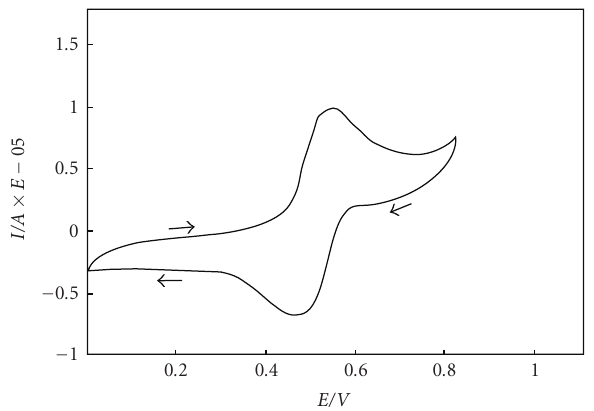
Figure 2: Cyclic voltammogramm of promazine (PM) at Pt electrode C PM = 5 · 10 − 5 M, in a mixture of 5 · 10 − 1 MK 2 SO 4 and 5 · 10 − 1 MKHSO 4 (pH = 1 . 3), scan rate 50 mV/s; in potential window 0.0–1.05